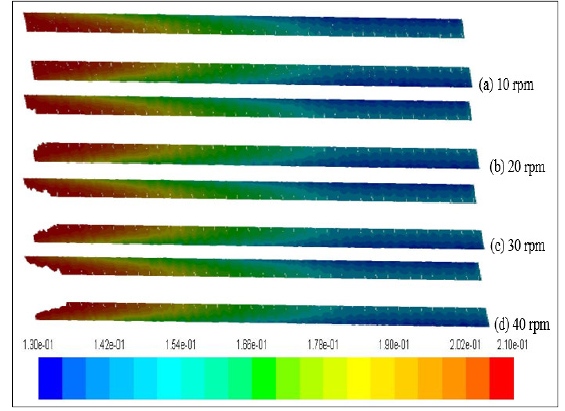
Fig. 12. Thermal conductivity Contour plane at 500 gm.